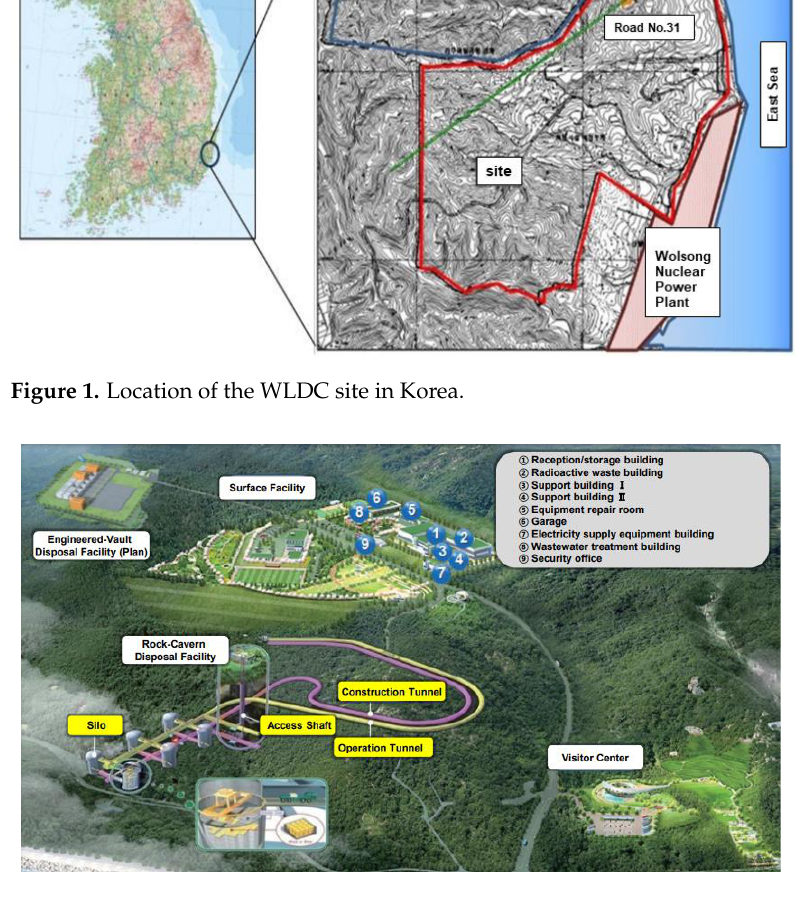
Figure 2. Layout of LILW disposal facilities.